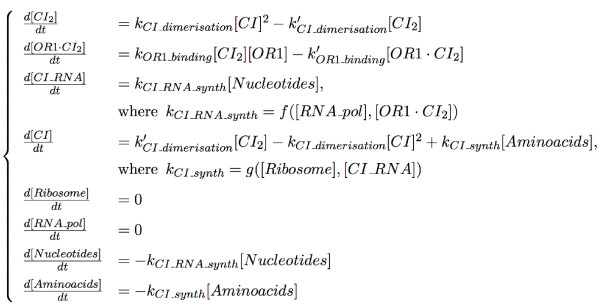
Differential equations obtained by an automatic translation of the MIN model in Figure 4. Functions f and g come, on one hand, from the MIN topology and the information on the stoichiometry of the reaction, and on the other hand, from the reaction attribute. At this stage, the coherence of both informations should be checked by an expert. In these equations f and g have a definite signature reflecting the impact of the catalyzers and inhibitors on the reactions.